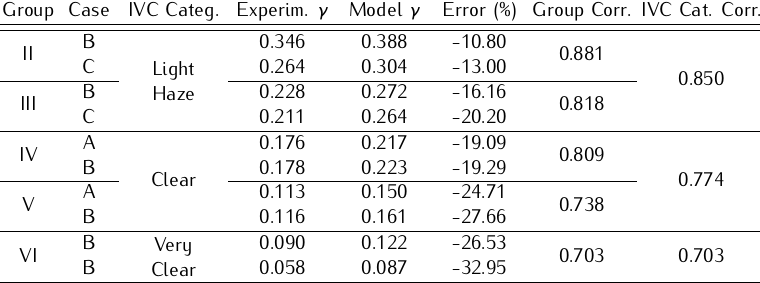
Table 14. Transmittance data and ESLM model corrections ( λ = 1064 nm – SR = 5.5 km).